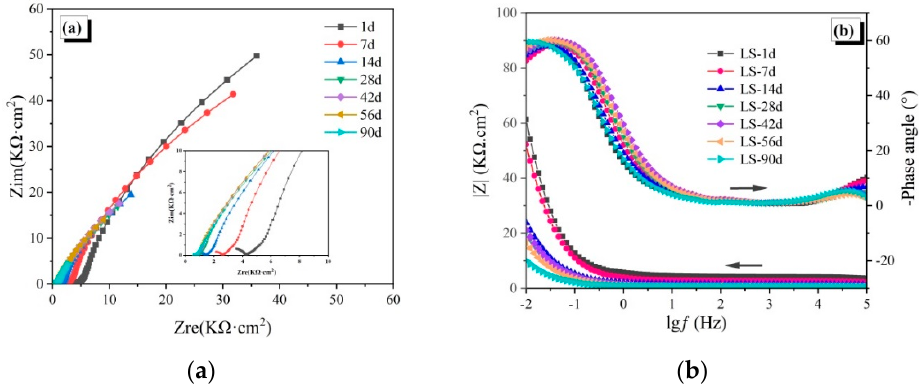
Figure 5. Electrochemical impedance spectroscopy of the LS-30 specimens: ( a ) Nyquist curves, ( b ) Bode curves.